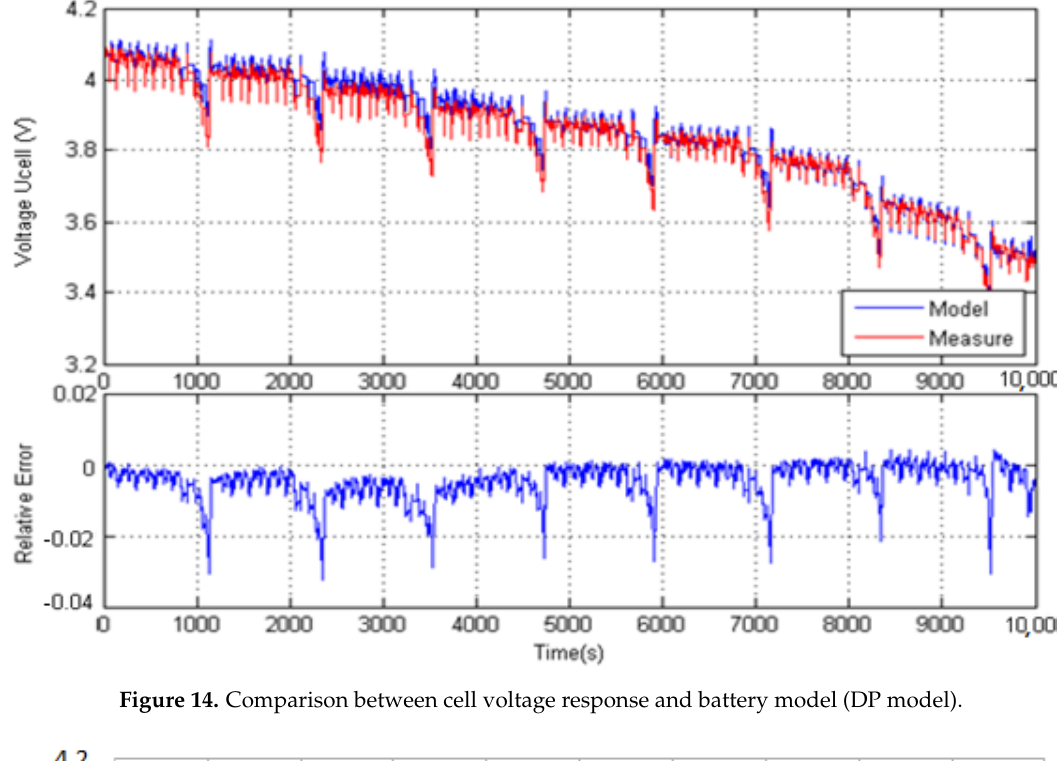
Figure 14. Comparison between cell voltage response and battery model (DP model).